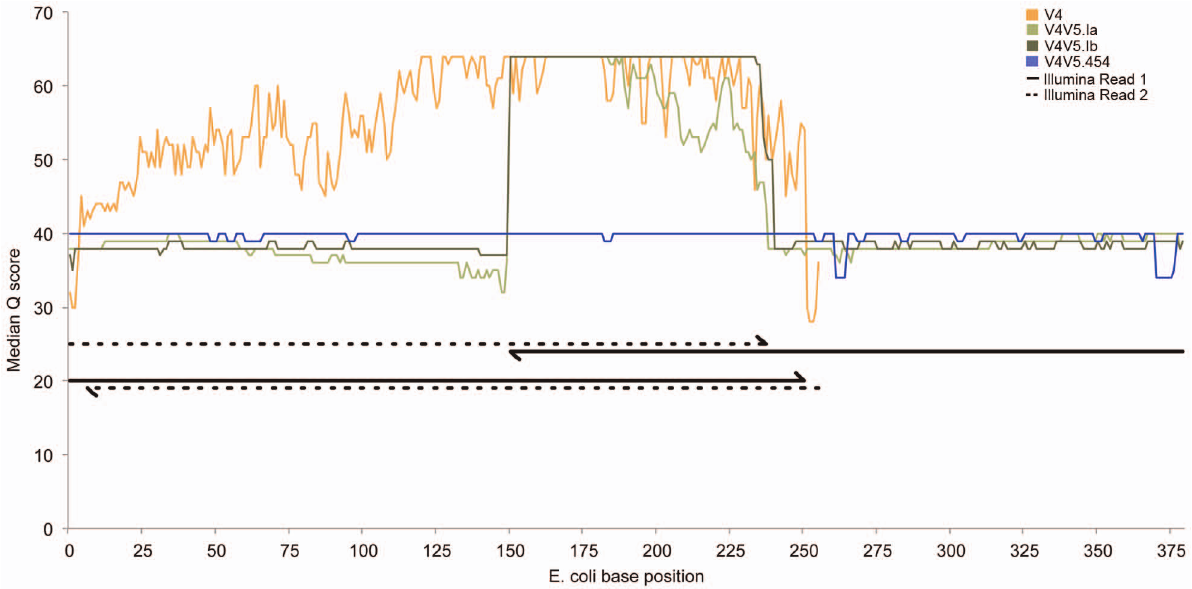
Figure 1. Comparison of 454 and Illumina sequence quality. Plot depicting the median per base PHRED quality scores ( Q score) for the full length 454 and merged Illumina reads from the six natural community samples. The V4 data is shown in orange, the first V4-V5 Illumina run (V4V5.Ia) is in light green, the second run (V4V5.Ib) is in dark green, and the 454 data is in blue. The size and over-lapping regions of the V4 and V4-V5 Illumina amplicons is shown in black below the quality plots. Illumina sequencing read 1 is depicted as a solid line while read 2 is dashed, with arrow heads depicting the direction of the read in reference to the E. coli base position given along the X axis.